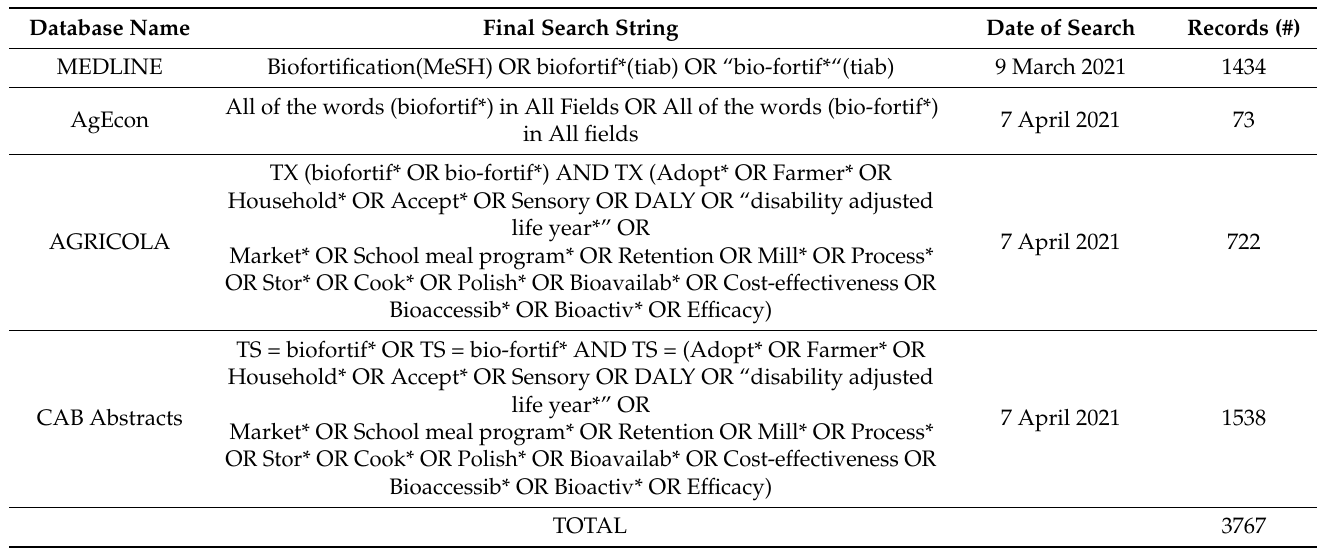
Table 1. Search strategy across included databases.